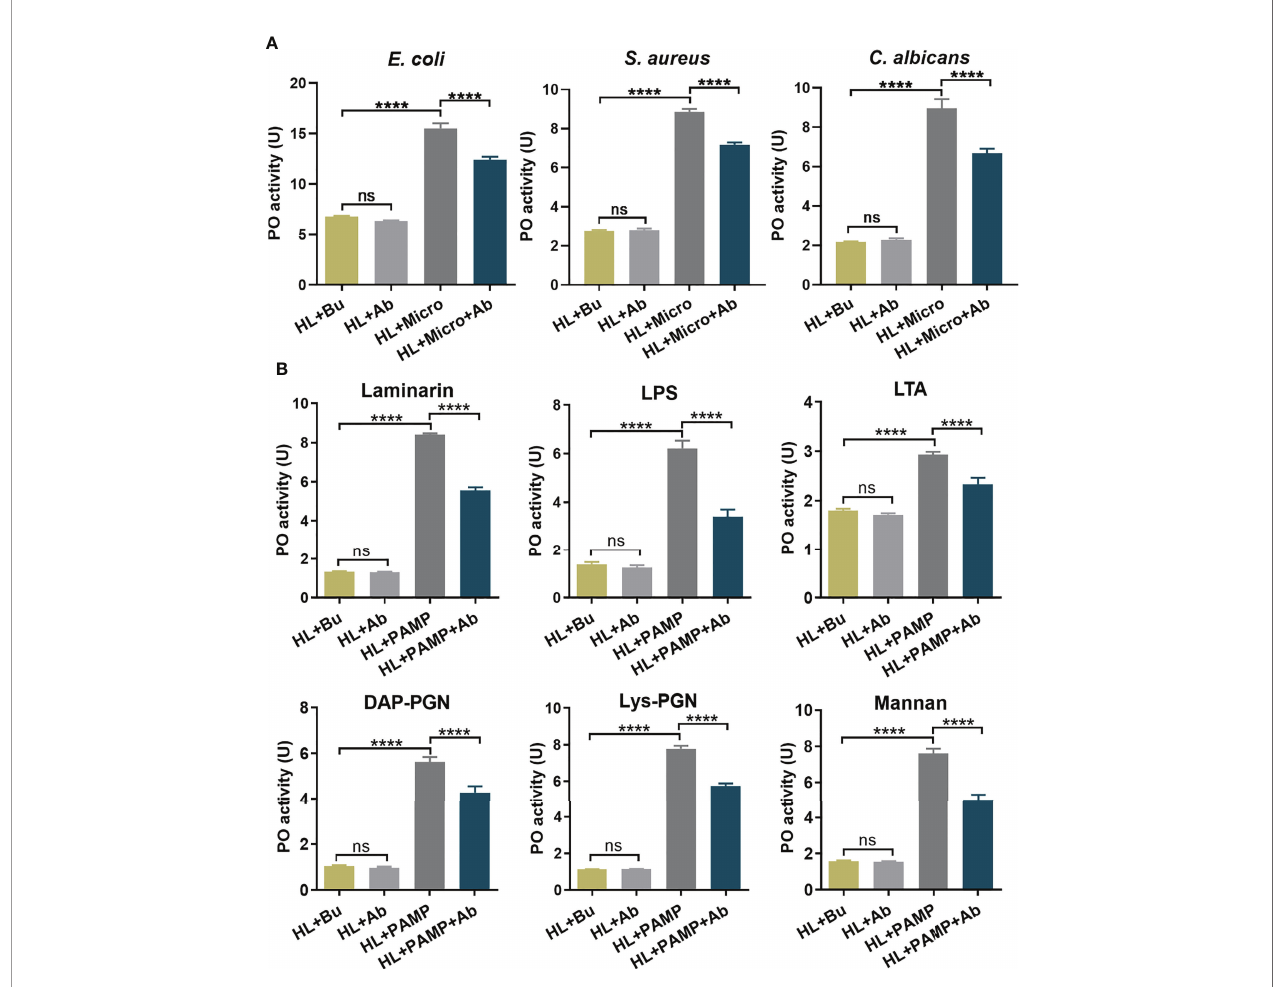
FIGURE 7 | Pathogen dependent PO activation in Ap -hemolin blocked plasma. Hemocyte-free plasma samples were pre-incubated with anti-His 6 - Ap -hemolin antibody and 20 mM Tris-HCl, pH7.0, respectively. PO activity of these samples triggered by microbes (A) and soluble PAMPs (B) was examined and compared. HL: native cell-free hemolymph (total protein: 12 mg/ml); Bu: 20 mM Tris-HCl, pH7.0; Ab: anti-His 6 -hemolin antibody (0.8 mg/ml). Each bar represents the mean ± SD (N=3). ****: p<0.0001, ns, no signi fi cant